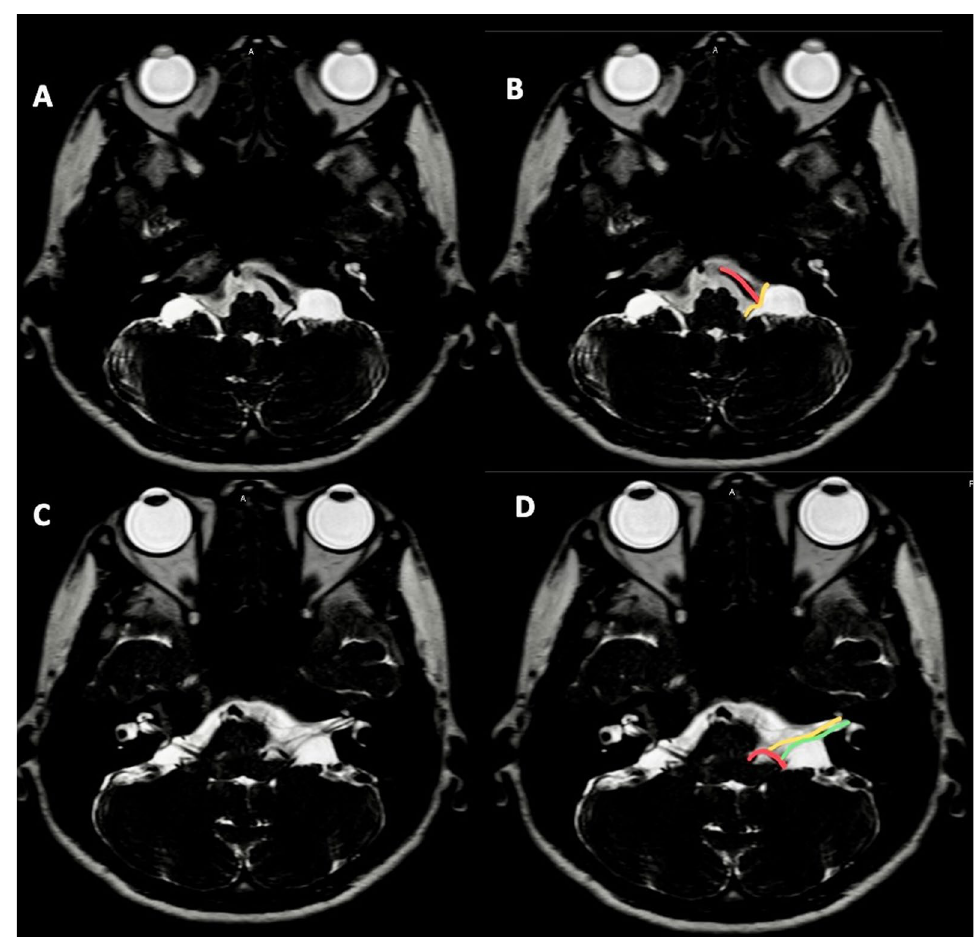
Fig. 1 Axial 3D-FIESTA MRI of the brain. A , B At the level of medulla, left PICA (red line) crossing left CN IX (yellow line) was demonstrated; and C , D at the level of caudal pons, left PICA (red line) attaching the root exit zone of left CN VII (yellow line) and the root entry zone of left CN VIII (green line) was